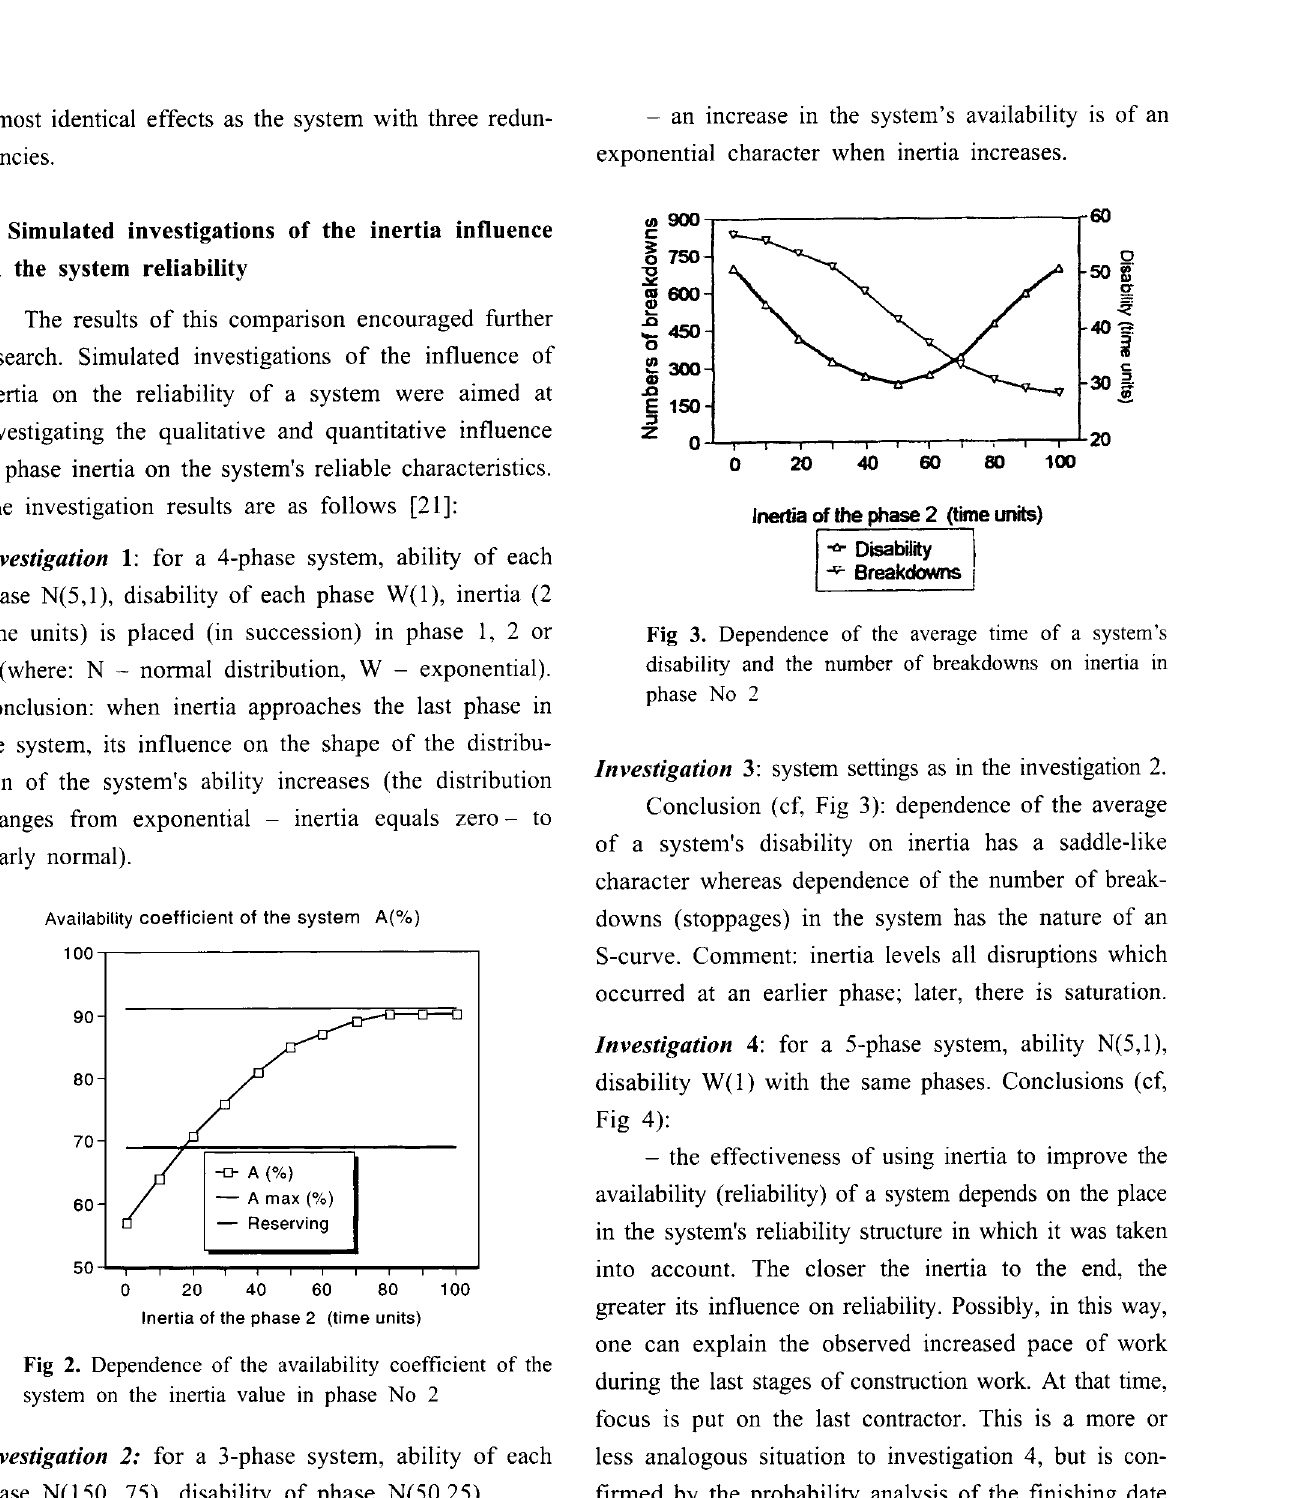
Fig 2. Dependence of the availability coefficient of the system on the inertia value in phase No 2 Investigation 2: for a 3-phase system, ability of each phase N{l50, 75), disability of phase N(50,25).